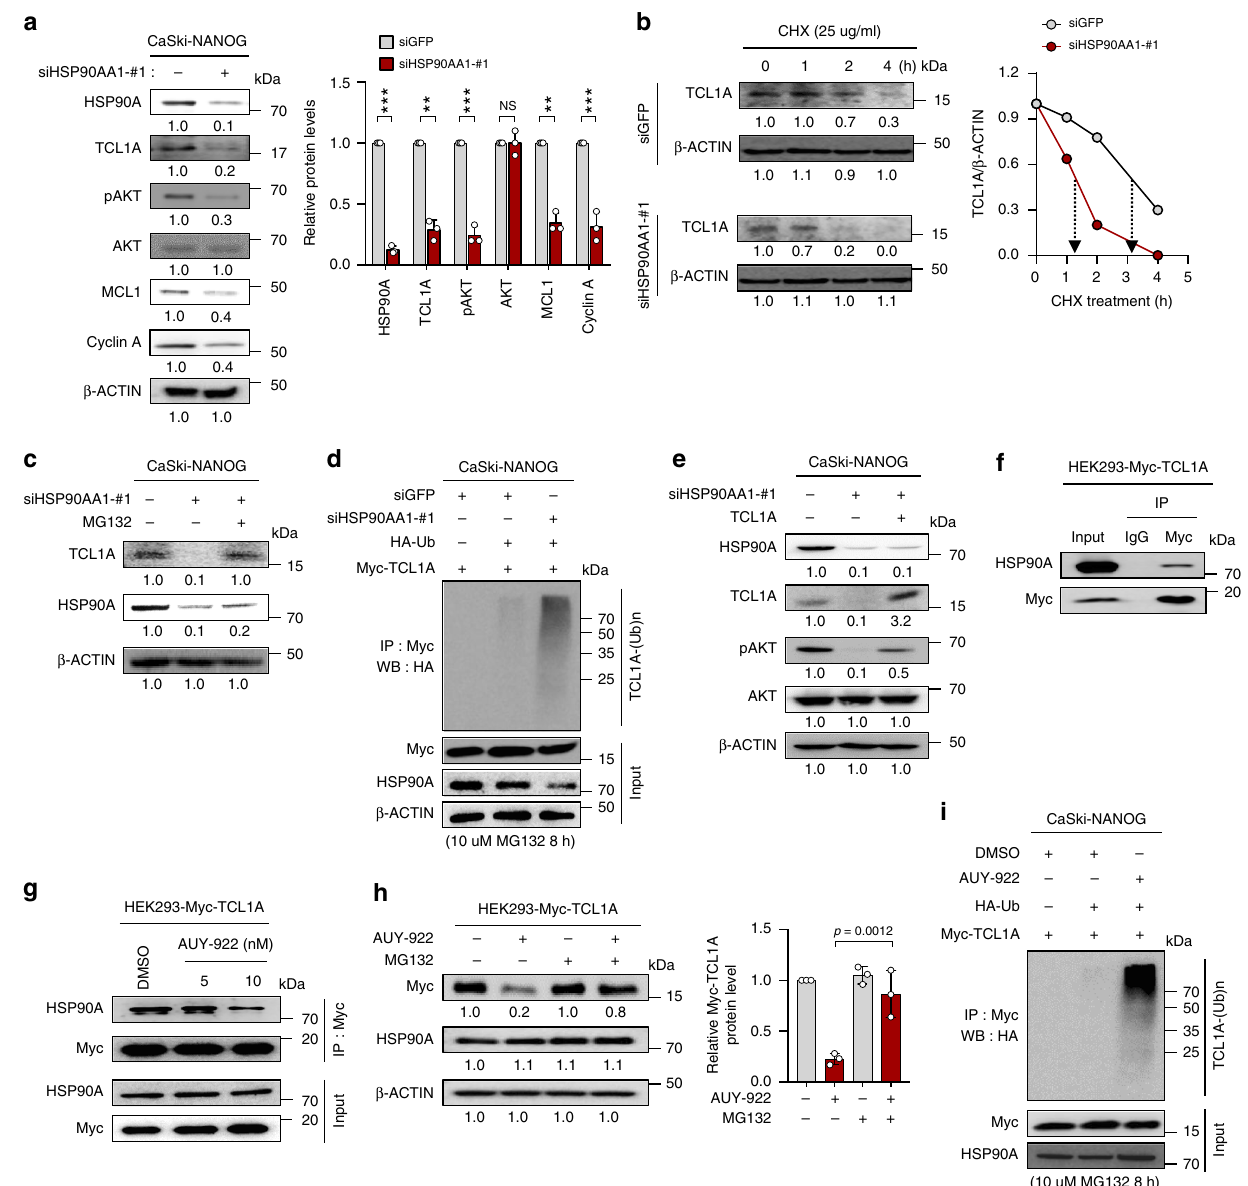
Fig. 4 HSP90A contributes to NANOG-induced AKT activation through TCL1A-stabilization. a – e CaSki-NANOG cells were transfected with siGFP or siHSP90AA1-#1. a Levels of HSP90A, TCL1A, pAKT, AKT, MCL1, and Cyclin A were analyzed by immunoblotting. Graph depicts the experimental quantitation based on at least three independent experiments. ** p < 0.001, *** p < 0.0001 by two-tailed Student ’ s t test. NS not signi fi cant. b The cells were treated with cycloheximide (CHX) for the indicated times. Cell lysates were subjected to immunoblotting with anti-TCL1A antibodies. Graph represents the means ± SD of three quanti fi ed data, after normalization to the corresponding β ‐ ACTIN level. c The cells were treated with or without MG132 (10 μ M) for 8 h. Cell lysates were subjected to immunoblotting with anti-HSP90A and anti-TCL1A antibodies. d The cells, transfecte d with indicated plasmids, were treated with MG132. Cell lysates were immunoprecipitated with anti-Myc antibody, and immunoblotted with the anti-HA antibody. The input represents 5% of total proteins. e siHSP90AA1-transfect e d CaSki-NANOG cells were transfected with TCL1A-Myc constructs. Levels of HSP90A, TCL1A, pAKT, and AKT were analyzed by immunoblotting. f HEK293 cells were transfected with TCL1A-Myc. g TCL1A-Myc-transfected HEK293 cells were treated with DMSO or AUY-922 as indicated. f and g Cell lysates were immunoprecipitated with anti-Myc antibody, followed by western blotting using anti-Myc and anti-HSP90A antibodies. h HEK293 cells, transfected with indicated plasmids, were treated with or without MG132 (10 μ M) for 8 h and were subjected to immunoblotting with anti-Myc and anti-HSP90A antibodies. Graph depicts the experimental quantitation of TCL1A protein level based on at least three independent experiments. The p -value by one-way ANOVA is indicated. i CaSki-NANOG cells were transfected with HA-Ub or TCL1A-Myc constructs and then were treated with DMSO or AUY-922 as indicated. Cell lysates were immunoprecipitated with anti-Myc antibody, and immunoblotted with the anti- HA antibody. The input represents 5% of total proteins. Numbers below blot images indicate the expression as measured by fold change a – c , e and h . All experiments were performed in triplicate. Data represent the mean ± SD a and h . Source data are provided as a Source Data fi